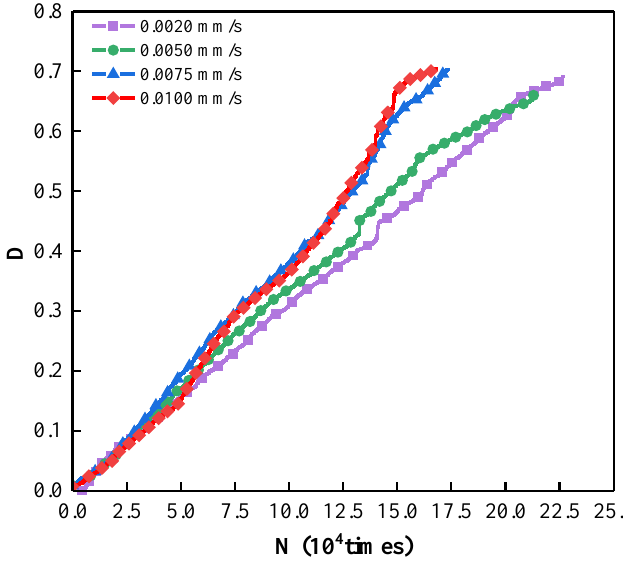
Figure 13. Relationship between N and D.